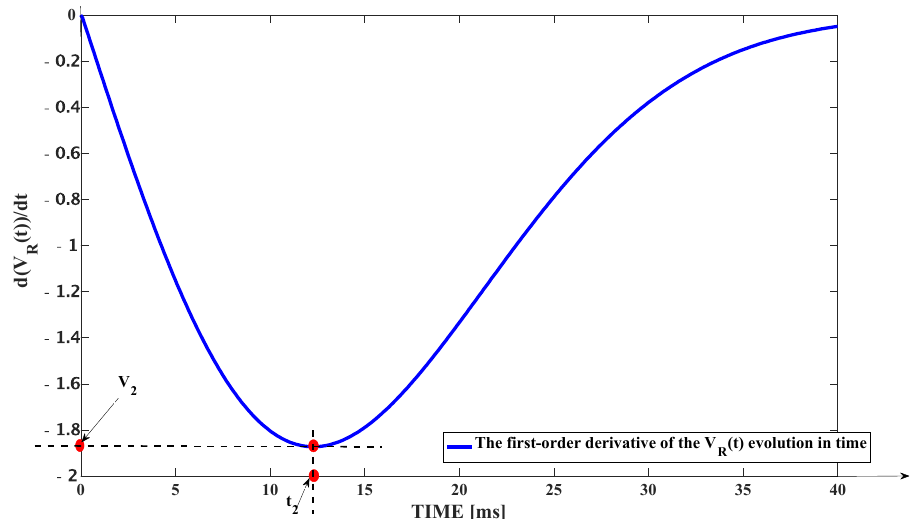
Figure 20. Dynamics of the first-order derivative of the V R (t) signal with respect to time in case of a persistent fault.